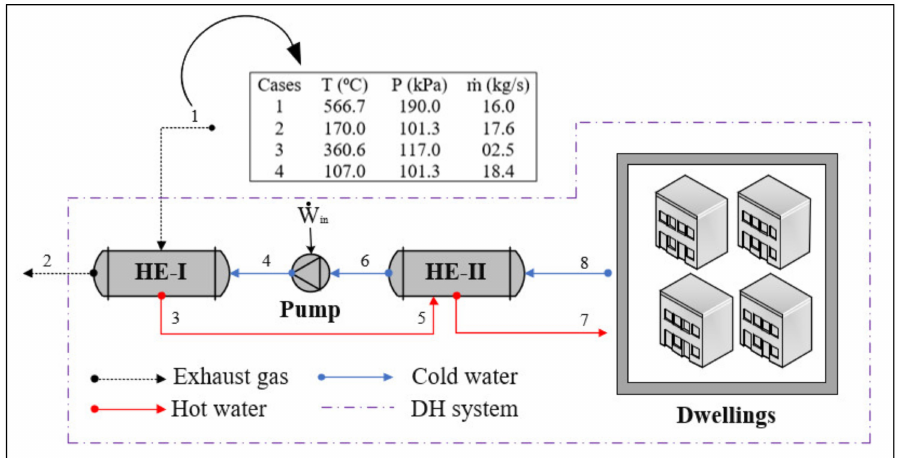
Figure 1. Topology of the studied